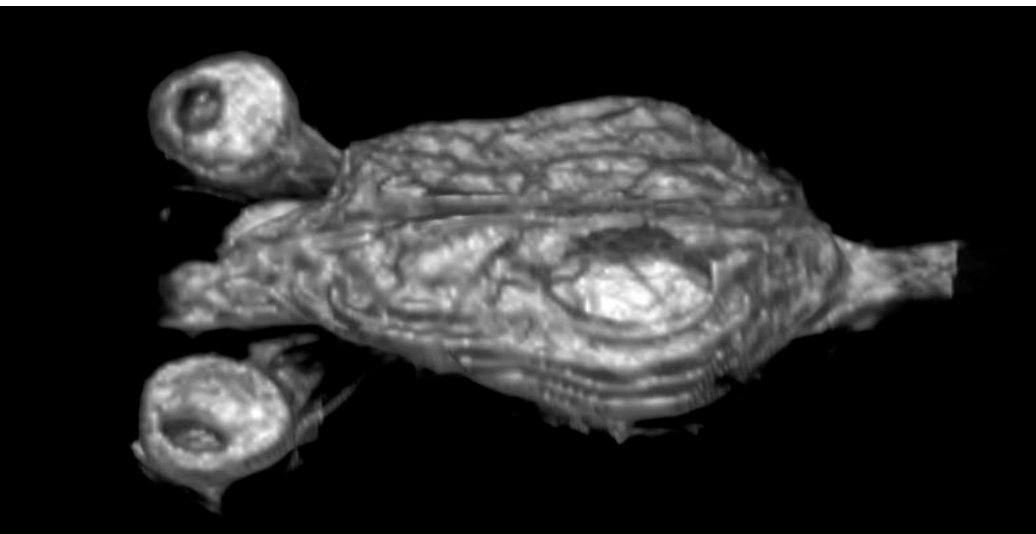
Fig. 6. 3D reconstruction of the dog's brain with post-traumatic changes (14 days after